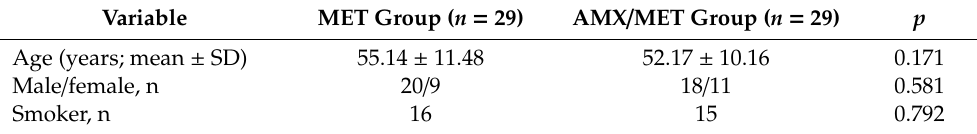
Table 1. Demographic data in the MET (subgingival instrumentation + metronidazole) and the AMX / MET groups (subgingival instrumentation + metronidazole / amoxicillin) at baseline (before subgingival